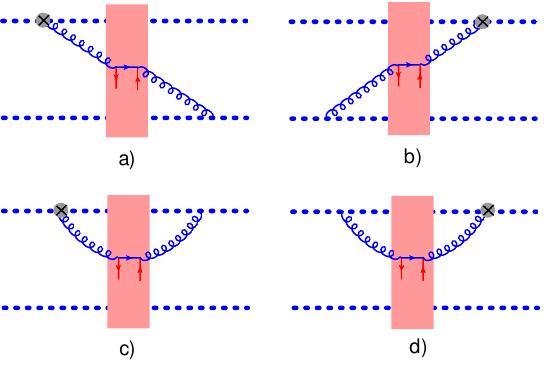
Figure 10 . Diagrams with F ij outside shock-wave. Here the gluon propagator, which represent the quantum loop, has quark sub-eikonal